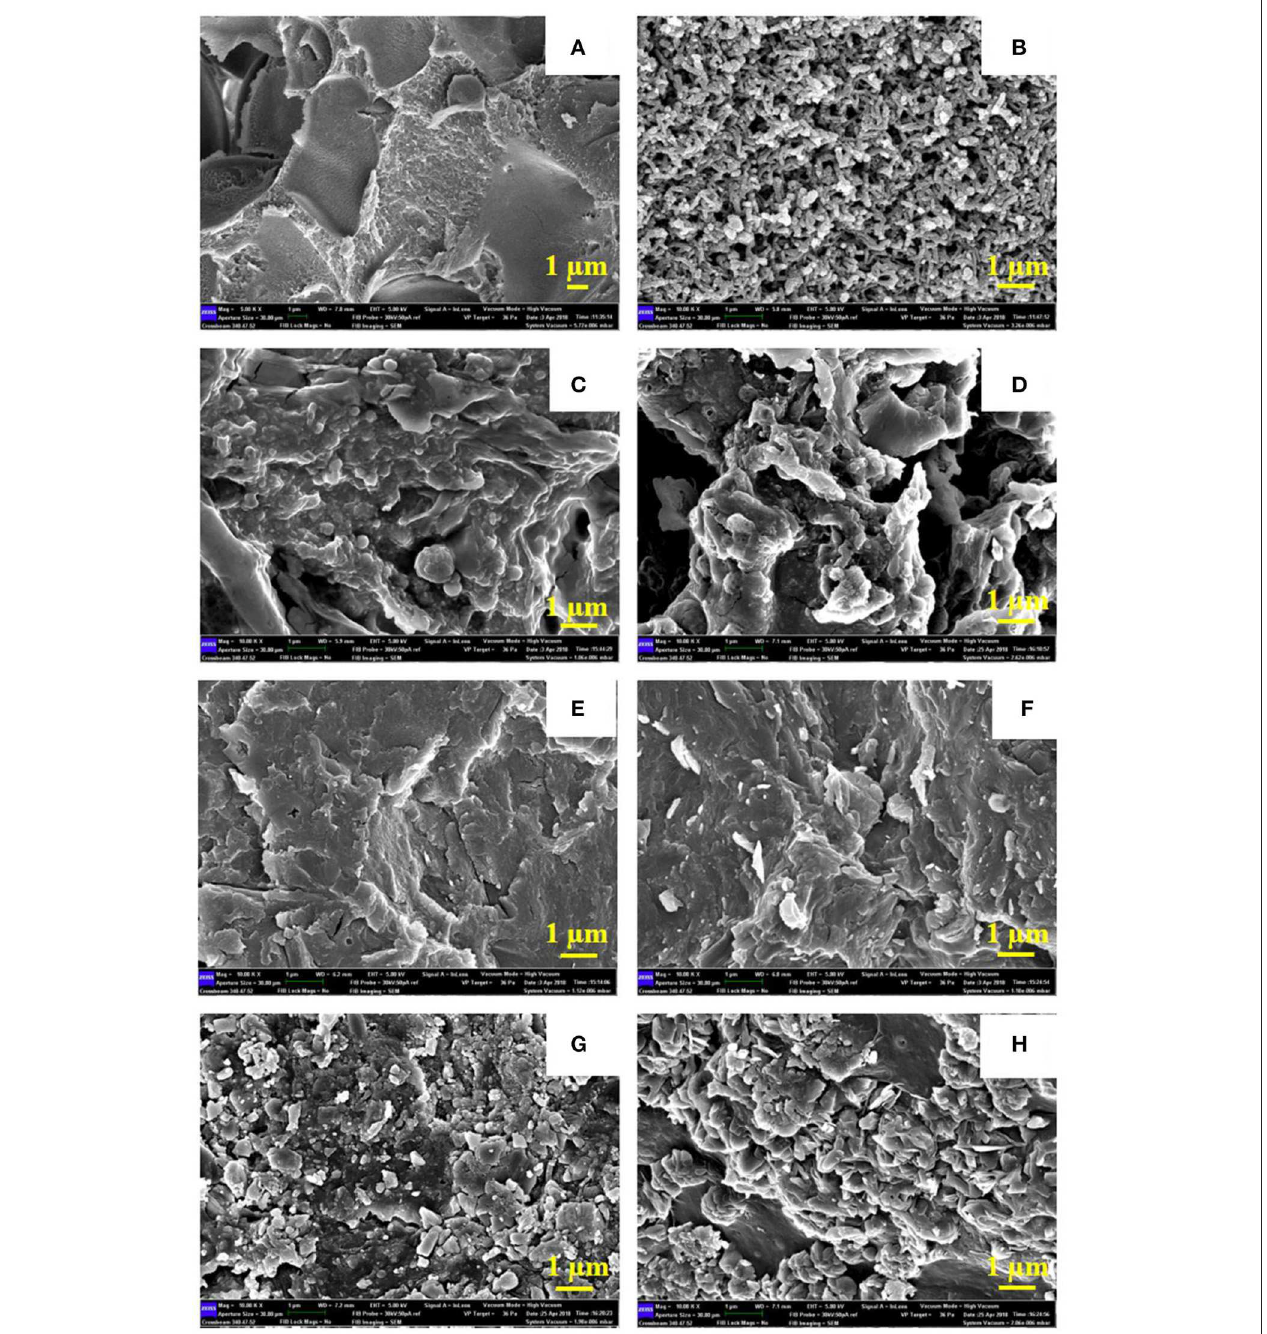
FIGURE 6 | FE-SEM of PANI, Sago, and PANI/Sago blends of varying pH. (A) Neat Sago. (B) Neat PANI. (C) P/S 2. (D) P/S 4. (E) P/S 6. (F) P/S 7. (G) P/S 9. (H) P/S 11.